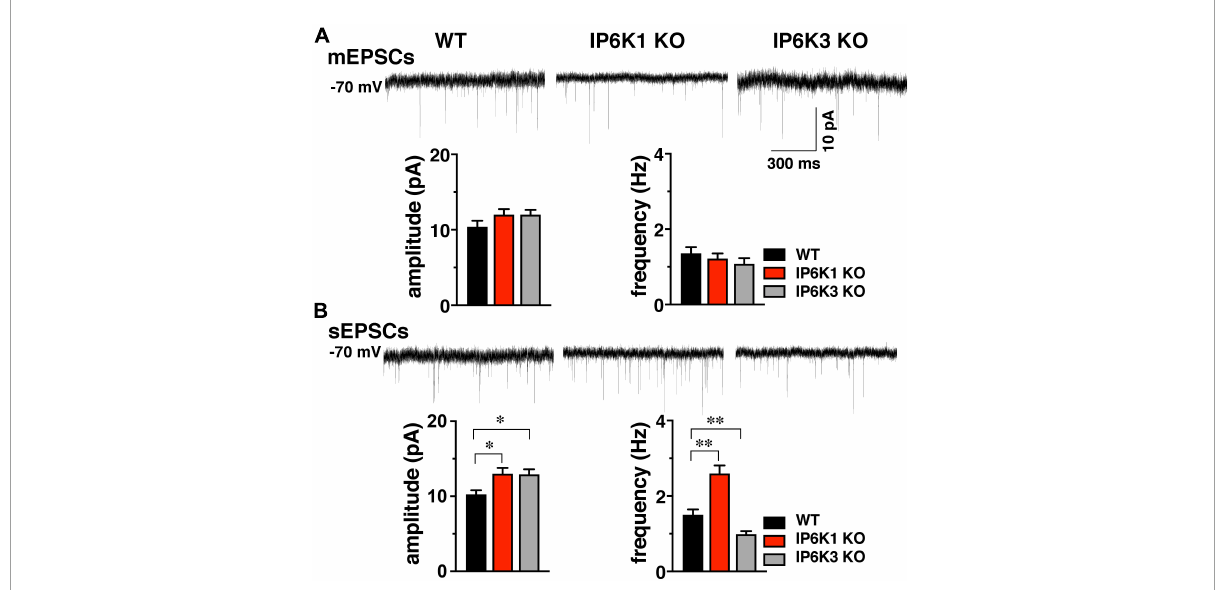
FIGURE4 Effect of IP6K KOs on EPSCs in striatum, which contains both VGLUT1 and 2 synapses. (A) Top: representative mEPSC traces from WT ( n = 10) and IP6K1 ( n = 12) and IP6K3 ( n = 8) KO mice under voltage clamp at –70 mV in the presence of 1 µ M TTX. Bottom: averaged amplitudes and frequencies indicate no differences between genotypes. (B) Top: representative traces of spontaneous EPSCs. Bottom: average sEPSC amplitudes are larger in both IP6K1 ( n = 9) and IP6K3 ( n = 10) KO mice, compared to WT ( n = 8). Frequency of sEPSCs is increased in IP6K1 KO and decreased in IP6K3 KO, compared to WT. ∗ p < 0.05, ∗∗ p < 0.01,